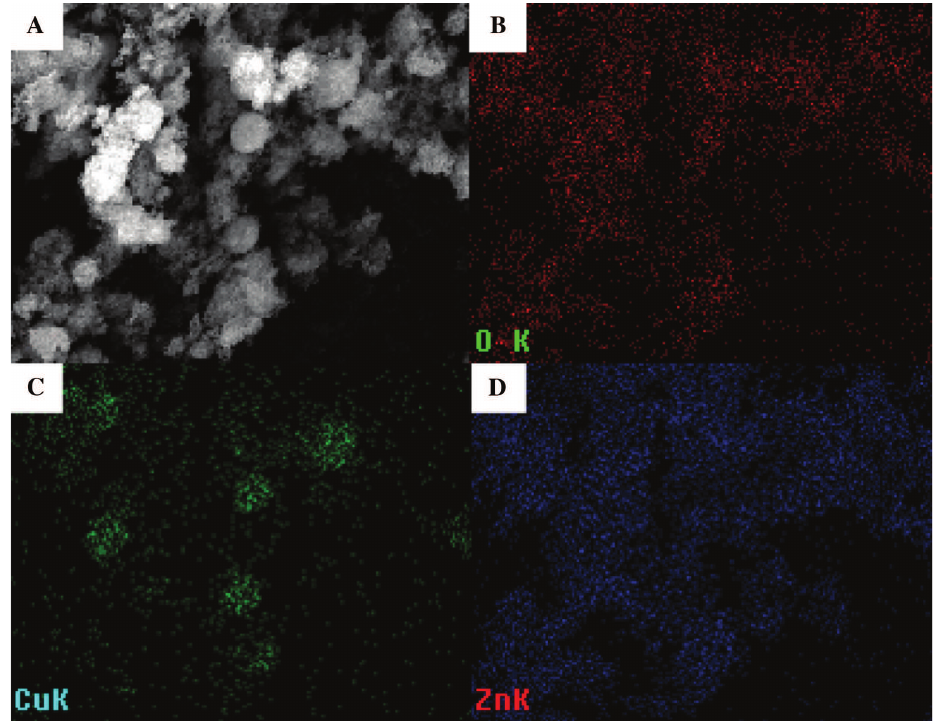
Figure 3: Mapping of Cu 2 O/ZnO (sample II). Cu 2 O/ZnO (A), distribution of O (B), Cu (C), Zn (D).